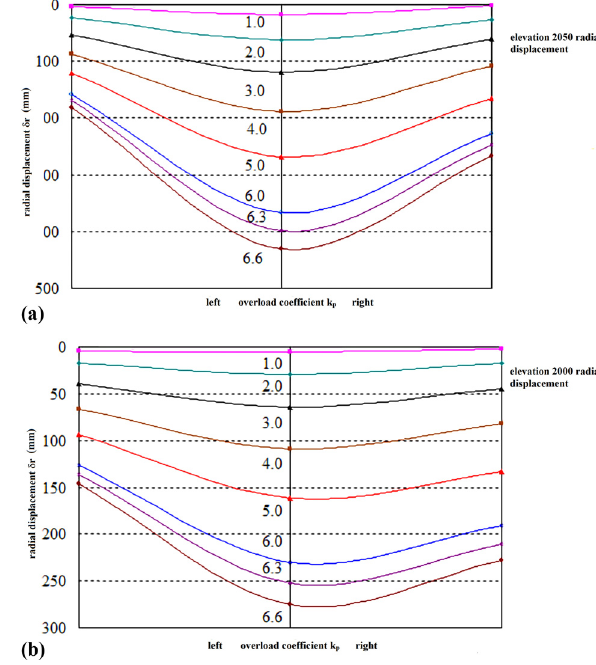
Figure 11: ( a ) Radial displacement δ r change process of the down - stream surface of the arch ring at an elevation of 2,050 m. ( b ) Radial displacement δ r change process of the downstream surface of the arch ring at an elevation of 2,000